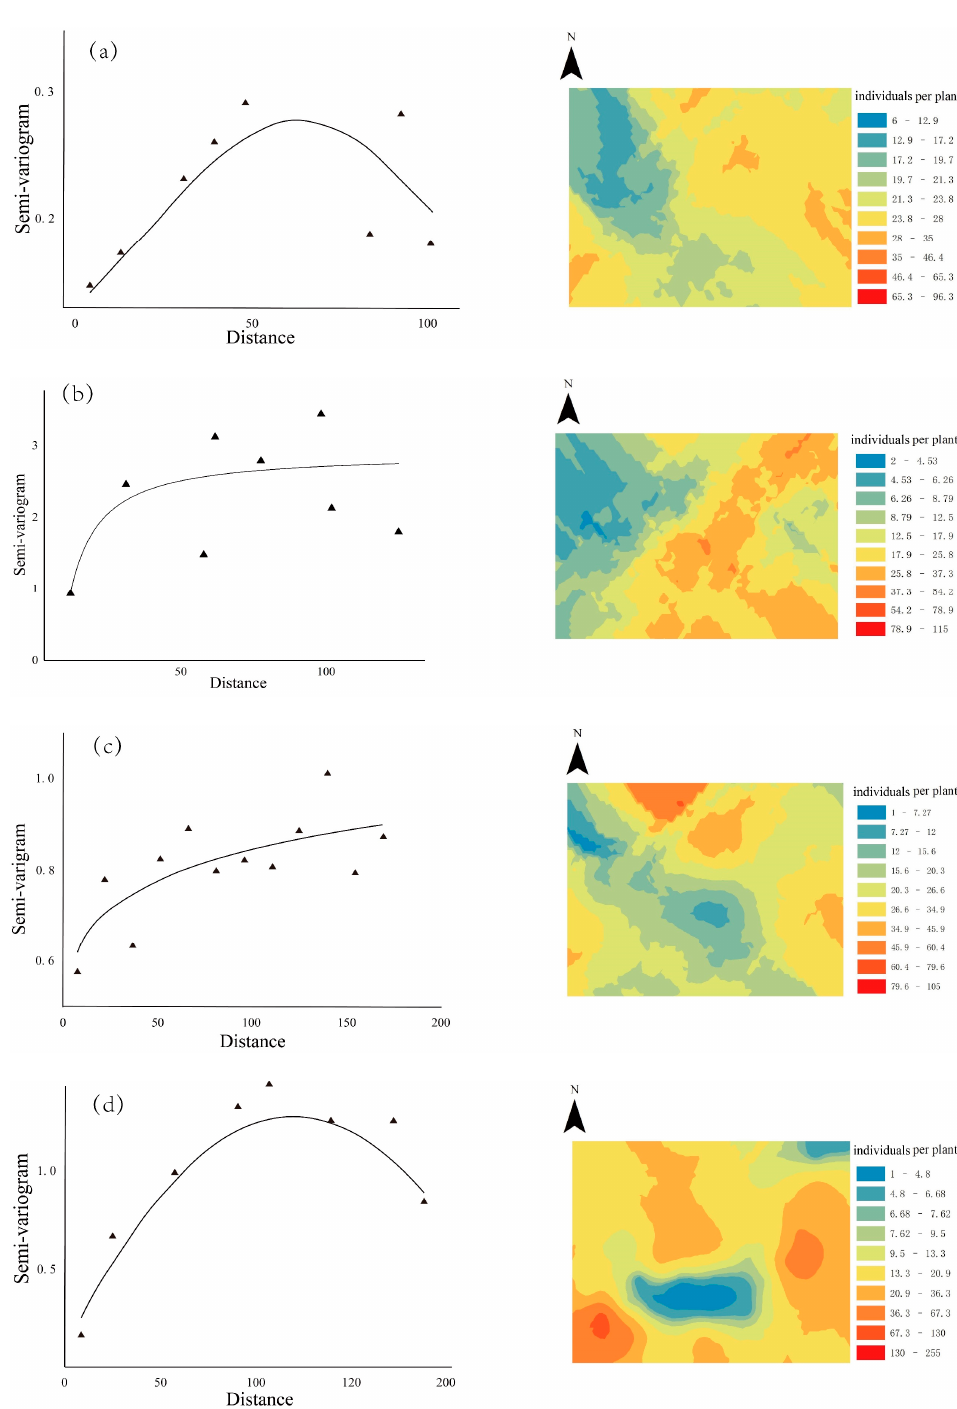
Figure 5. Semi-variogram curves (left panels) and kriging maps (right panels) of spatial patterns for C. aeruginosa larvae for the mean number of larvae ( a ), 1st and 2nd instar larvae ( b ), 3rd instar larvae ( c ), and 4th instar larvae ( d ).